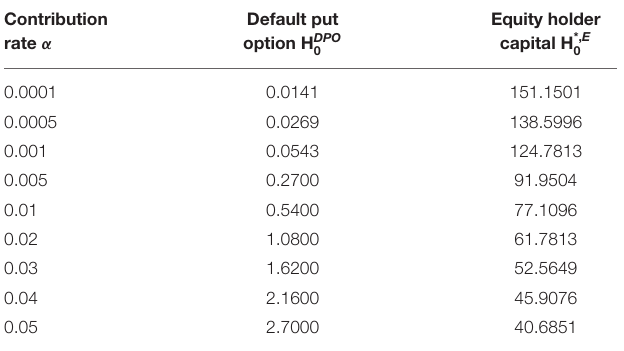
TABLE 8 | Shortfall probability and expected policyholder deficit before and after introducing PCIS in insurer and policyholder paying